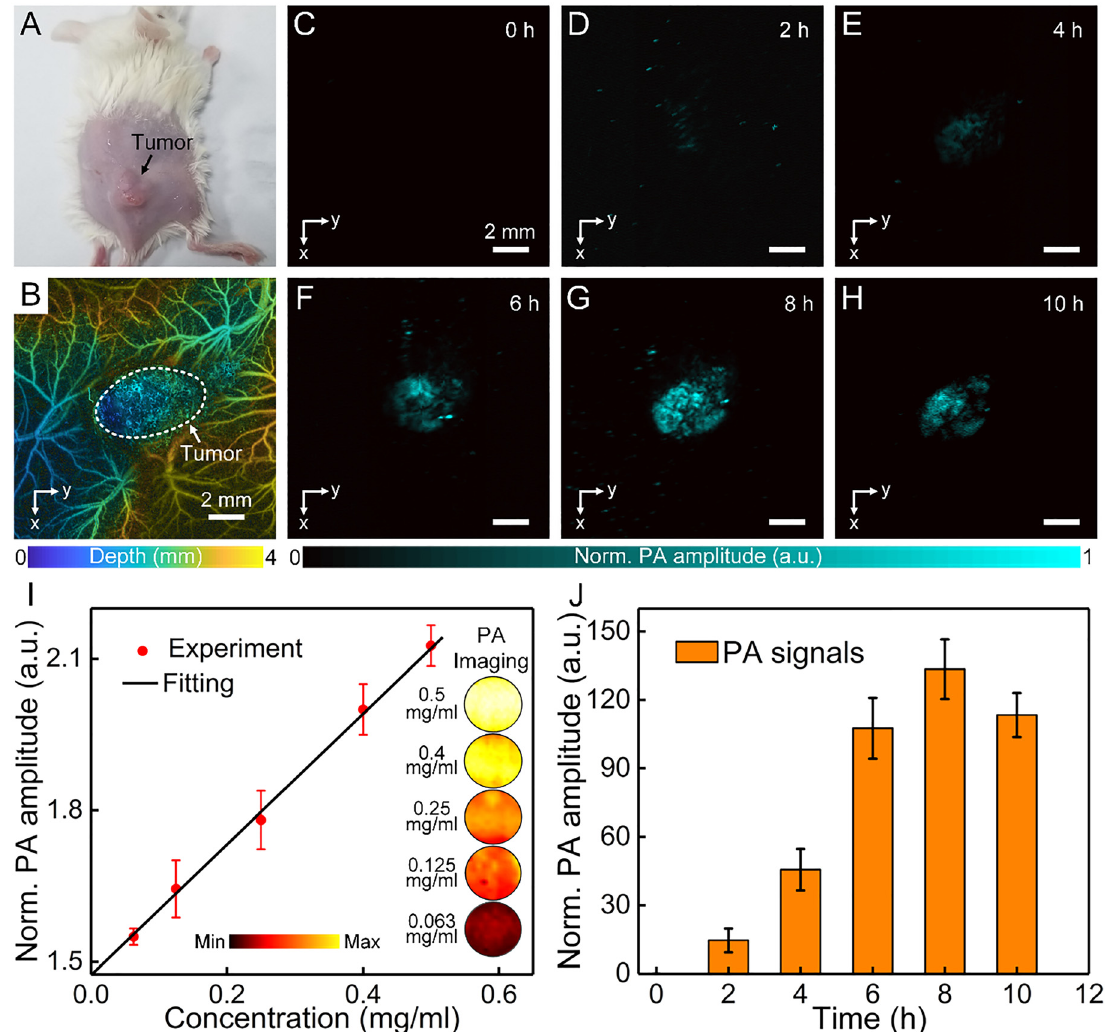
Figure 5: In vivo monitoring of tumors undergoing different photothermal treatments. (A) The photograph of 4T1 tumor model. (B) Microvascular morphology of the tumor region was imaged with 532 nm laser. (C) – (H) In vivo non- invasive 750 nm laser PA imaging results of mice in 4T1 tumor model at different time points after Den-RGD/Cy7 nanoparticle via tail vein injection. (I) The imaging results and the PA signals statistics of nanoparticles at different concentrations under 750 nm laser. (J) PA signals amplitude of nanoparticle in the tumor